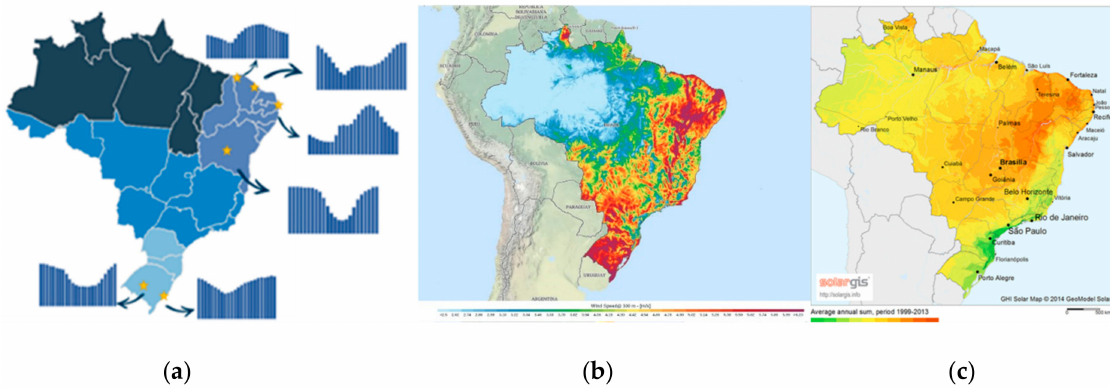
Figure 3. Wind profiles ( a ) and zones with high wind ( b ) and solar ( c ) potential in